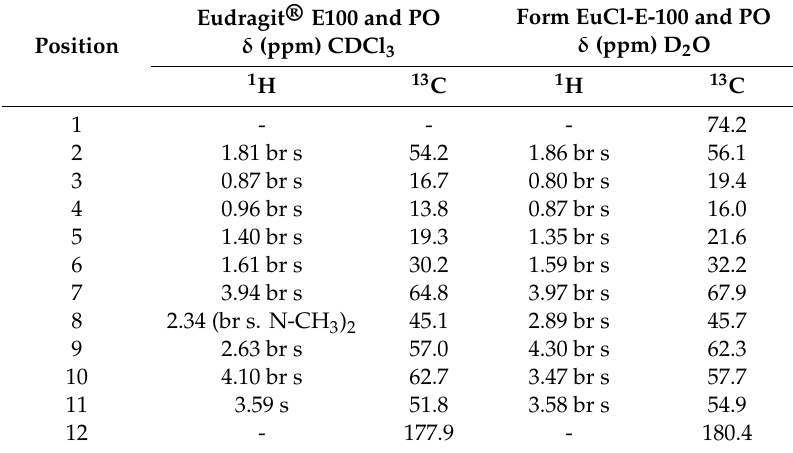
Table 2. Summary data for the proton and the carbon NMR spectra of Eudragit ® and its processed forms. Eudragit ® E100 and Position